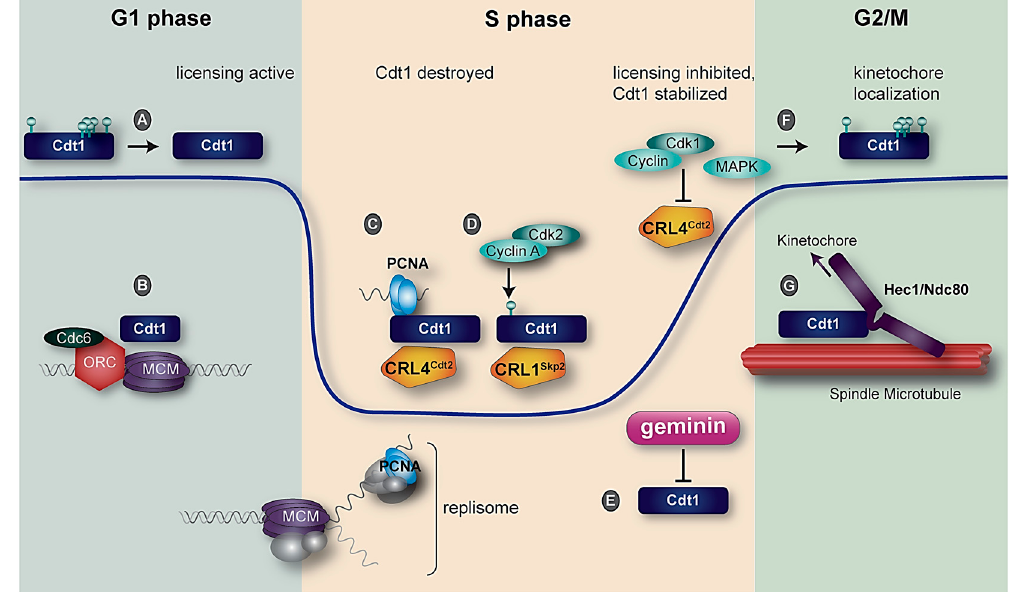
Figure 3. Human Cdt1 regulation during a single cell cycle. The blue line indicates relative Cdt1 protein abundance. ( A ). Cdt1 is dephosphorylated in early G1 by an unknown phosphatase; ( B ) Cdt1 participates with ORC and Cdc6 to load MCM hexamers onto DNA; ( C ) Proliferating Cell Nuclear Antigen (PCNA) loaded at DNA replication forks is bound by the Cdt1 PCNA ‐ Interacting Protein (PIP) degron, and the complex is recognized for ubiquitylation and subsequent proteasome ‐ mediated destruction by CRL4 Cdt2 ; ( D ) Cdt1 is phosphorylated at Thr29 by cyclin A/Cdk2 to create a phosphodegron recognized for ubiquitylation by CRL1 Skp2 . The combined action of two E3 ubiquitin ligases drives Cdt1 degradation in S phase; ( E ) The geminin protein begins to accumulate in early S phase, and peaks in late S phase and G2. Geminin binding blocks Cdt1 origin licensing function; ( F ) During late S phase and G2, mitotic kinases—especially cyclin A/Cdk1 and the stress ‐ activated MAP kinases p38 and c ‐ Jun N ‐ terminal Kinase (JNK)—phosphorylate Cdt1; Cdk1 also inactivates CRL4 Cdt2 ; ( G ) A subset of Cdt1 molecules is recruited to kinetochores in mitosis through interaction with the loop domain of Hec1. Cdt1 is required for stable kinetochore–microtubule attachment.